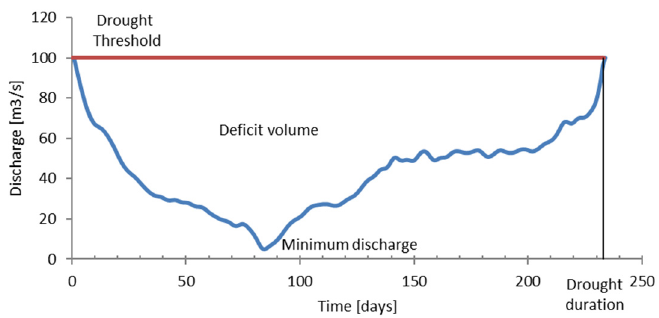
Figure 1. Hydrological drought parameters.